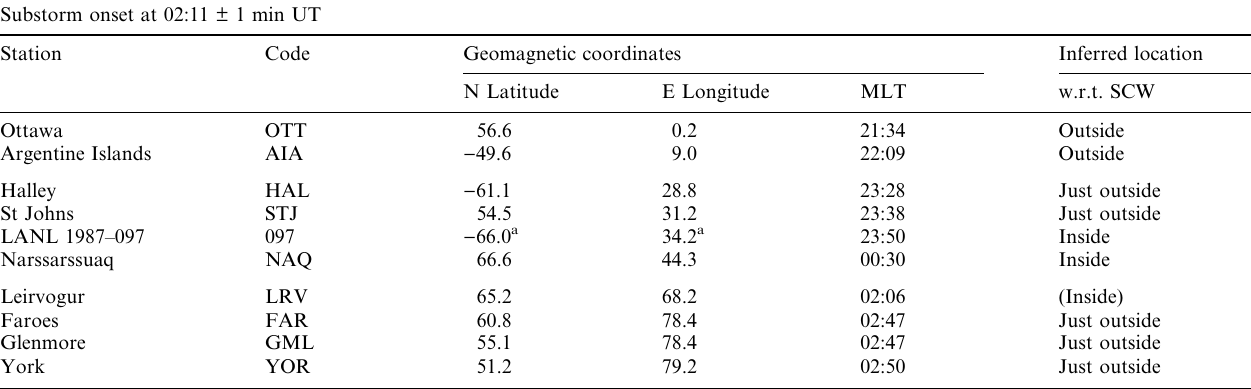
Table 1. The positions of ground magnetometers and geostationary spacecraft used to infer the location of the substorm current wedge Substorm onset at 02:11 (cid:139) 1 min UT